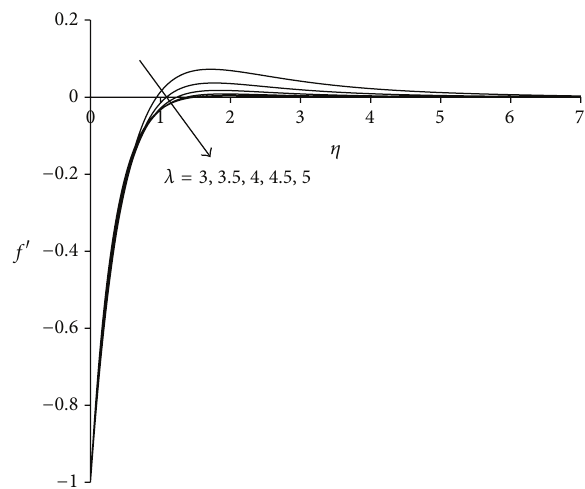
Figure 2: Velocity distribution for different 𝜆 (𝜏 = 1, 𝜎 = 3, Ec = 0.75) .